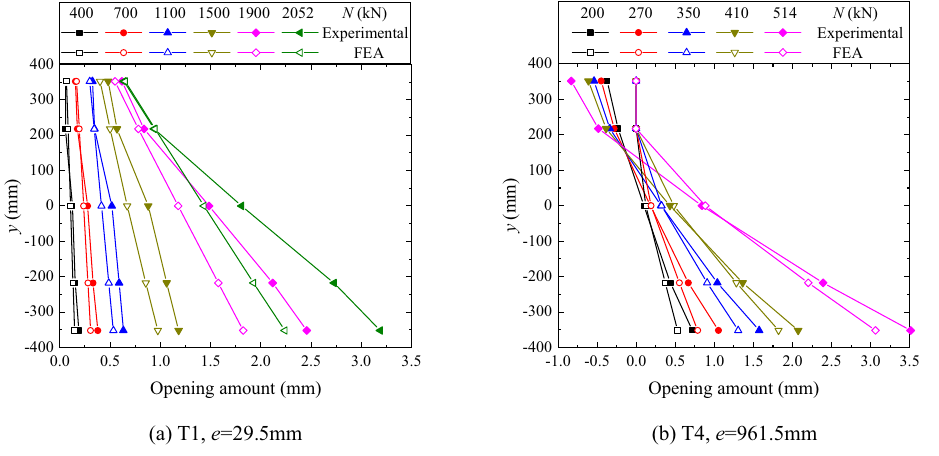
Figure 15. Distributions of opening amount.